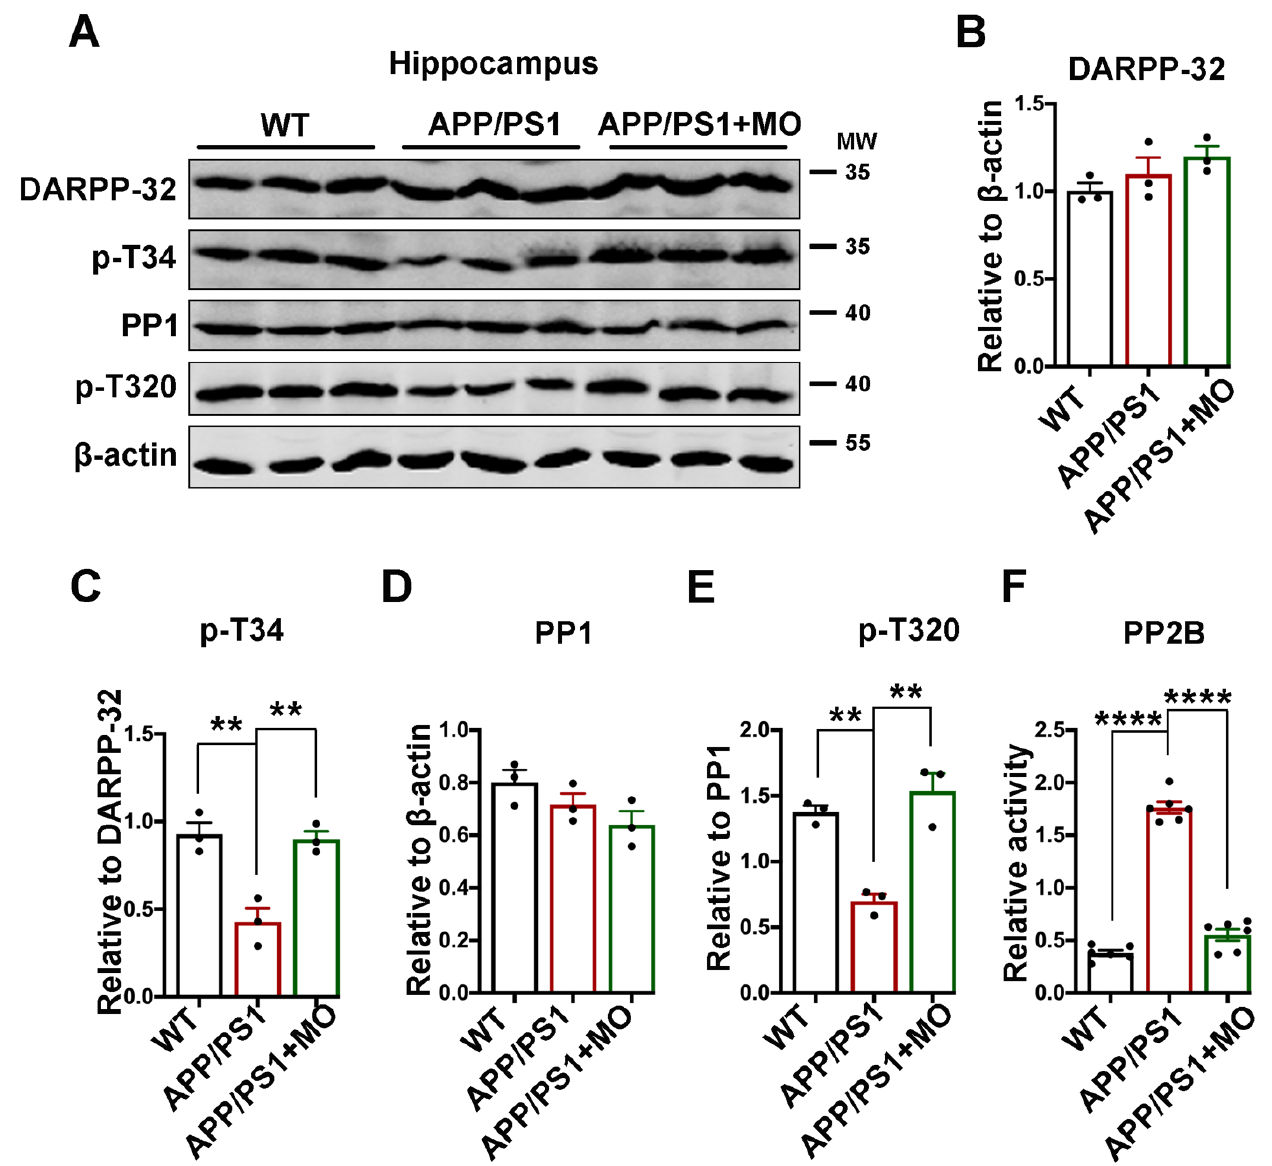
Figure 5. MO downregulates STEP by modulating the PP2B/DARPP-32/PP1 axis. ( A ) The expression level of DARPP-32, p-T34, PP1, and p-T320 from hippocampal lysates of WT control and APP/PS1 mice with or without MO treatment was evaluated by Western blotting, ( n = 3). ( B – E ) The statistical analysis of Western blot bands from panel A. β -actin serves as the loading control. ( F ) The statistical analysis of the PP2B activity test from hippocampal lysates of WT control and APP/PS1 mice with or without MO treatment, ( n = 4). The test was carried out using a PP2B activity kit. The data are presented as Mean ± SEM. ** p < 0.01 and **** p < 0.0001 vs. WT or vs. APP/PS1 mice groups. p-T34 = phosphorylated DARPP-32 at Thr34; p-T320 = phosphorylated PP1 at Thr320.